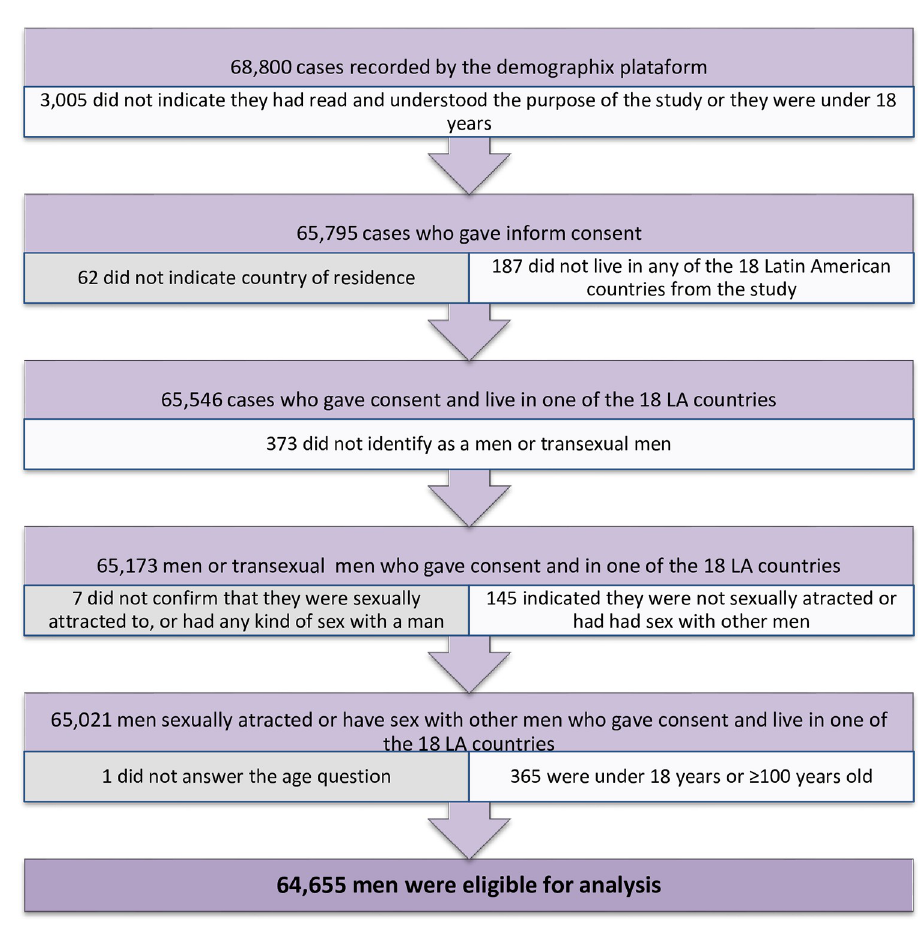
Fig 2. Data cleaning process from cases recorded online to final valid